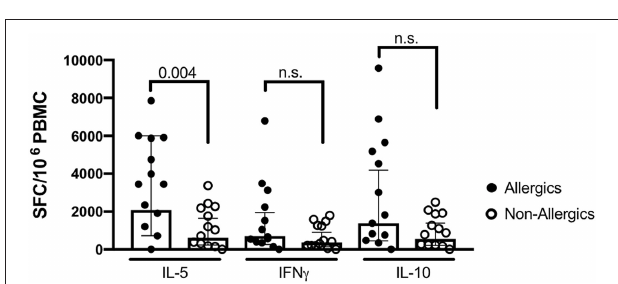
FIGURE 3 | T cell reactivity measured as spot producing cells (SFC) in allergic (black dots) and non-allergic (open circles) individuals in response to extract 7. Bars indicate geometric means, error bars represent 95% confidence intervals. Statistical comparison was performed by Mann-Whitney test, two-tailed. P < 0.05 is considered significant. N = 13 per